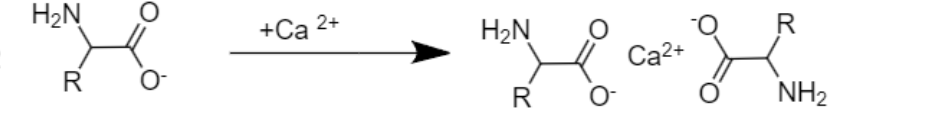
Table 3. Amino acid composition of protein hydrolysates.